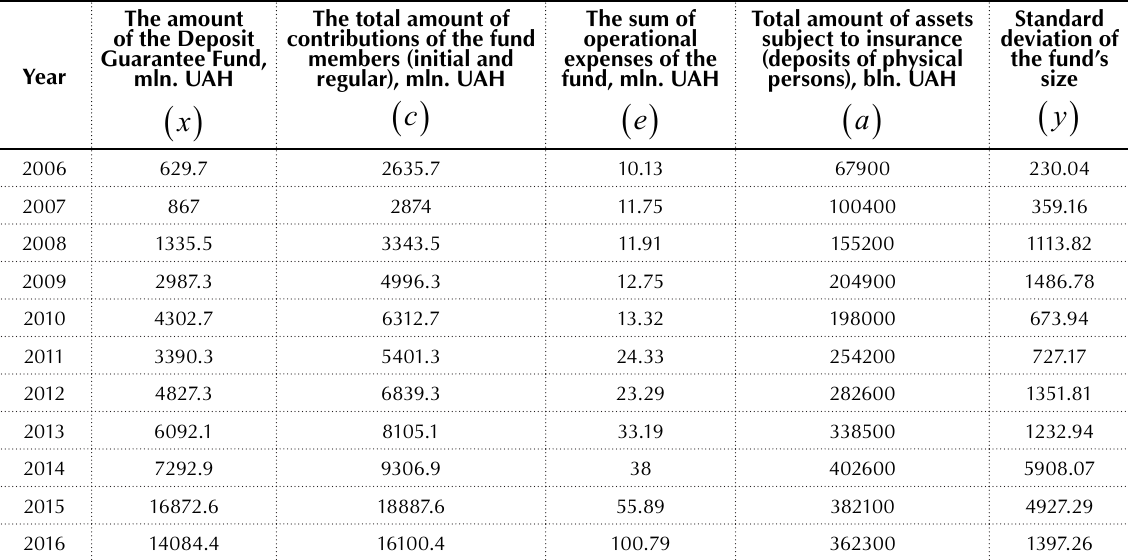
Table 1. Output data for calculating the optimal size of the Deposit Guarantee Fund for 2006–2016